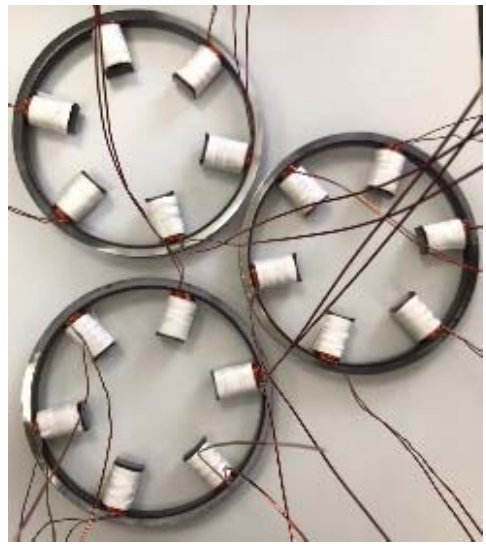
Figure 13. Stator and coils of the motor.